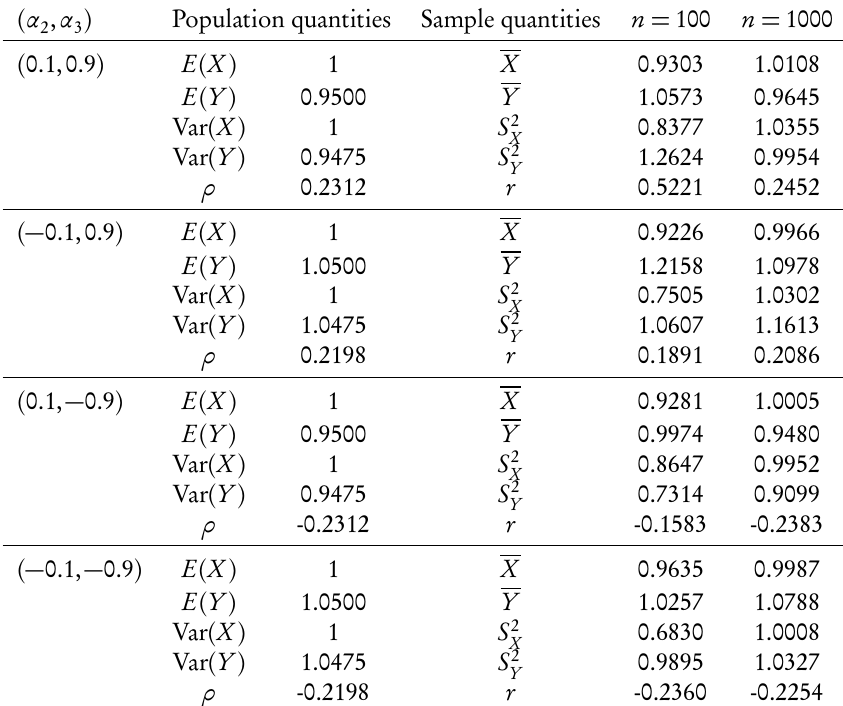
Sample and population quantities associated with the simulated